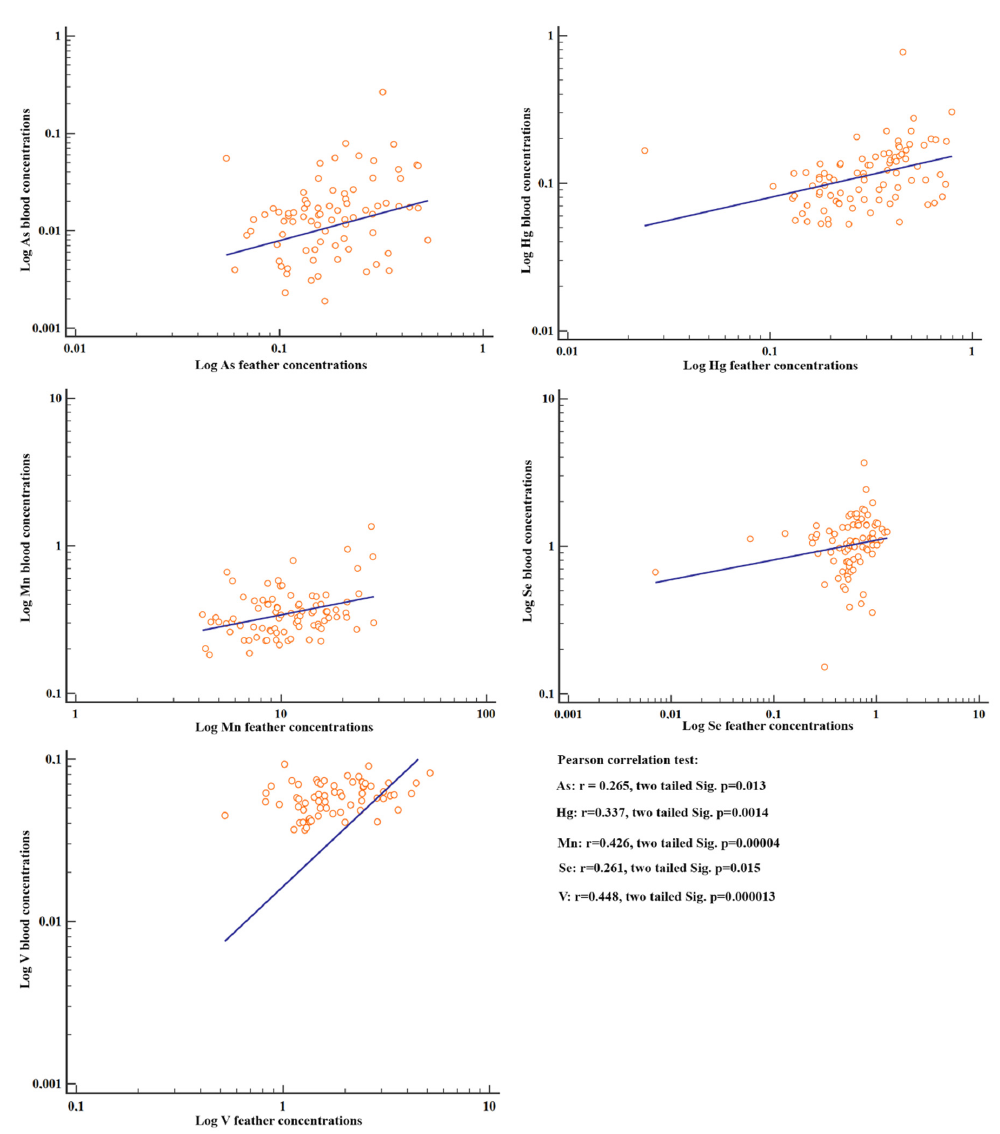
Figure 3. Scatter diagrams and regression lines of the metal concentrations with significant Pearson correlations between blood and feathers. Concentrations were log-transformed as log(y) ¼ a þ b log(x).